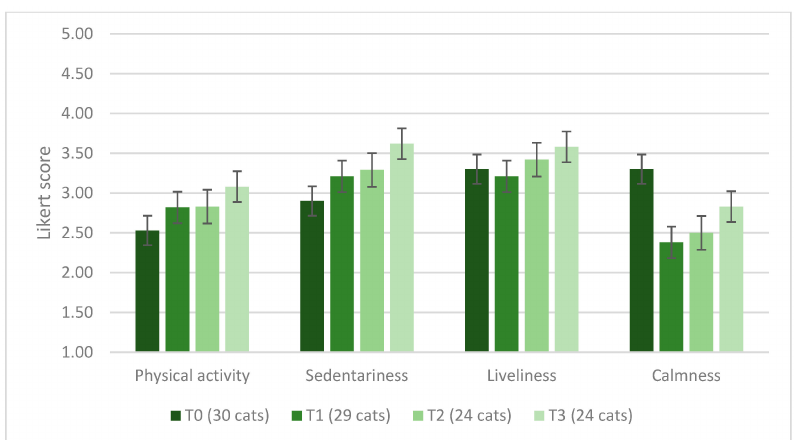
Figure 6. Average score on a Likert scale from 1, equal to “not at all”, to 5, equal to “very”, assigned by the owners evaluating the degree of physical activity, sedentariness, liveliness and calmness of their